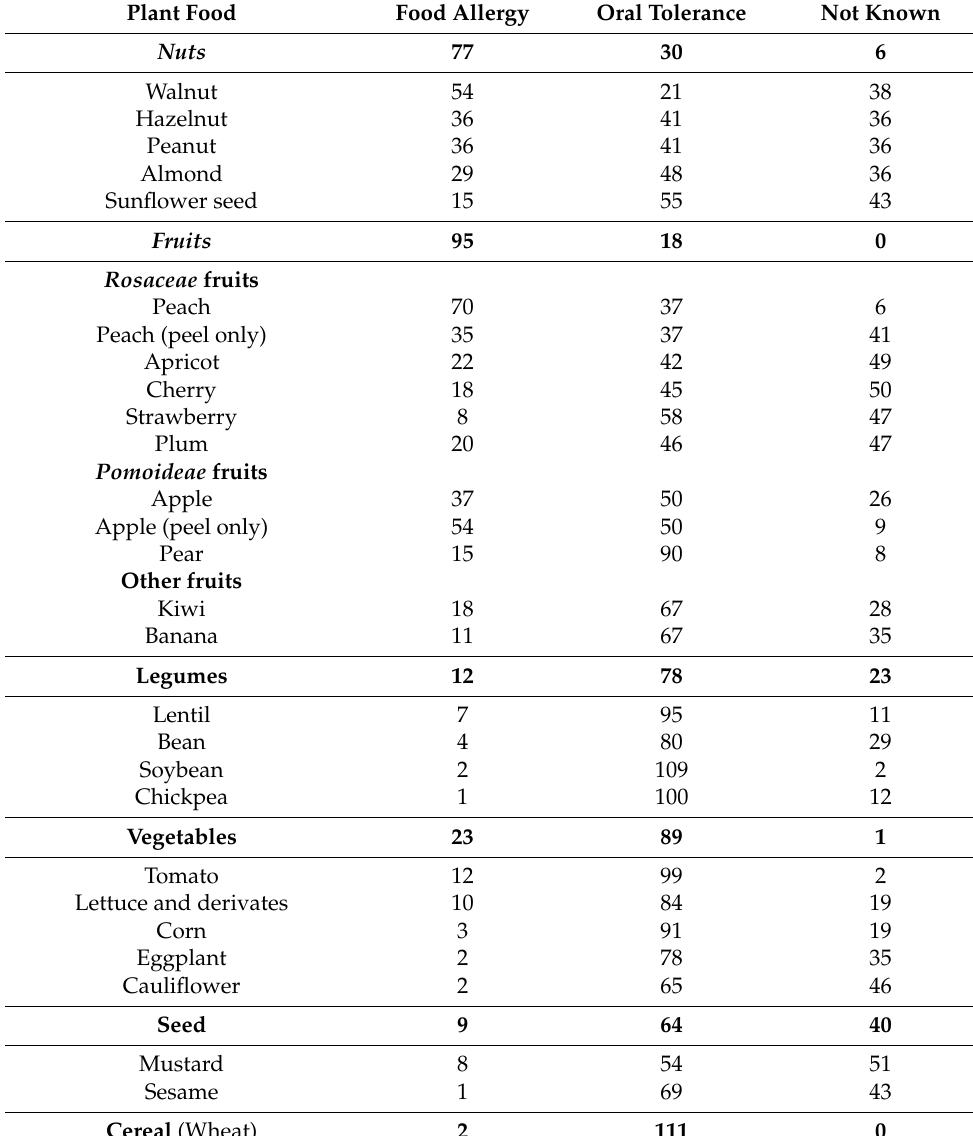
Table 2. Plant foods involved in the allergic reactions of nsLTP allergy group ( n = 113) at baseline. Results are shown in number of